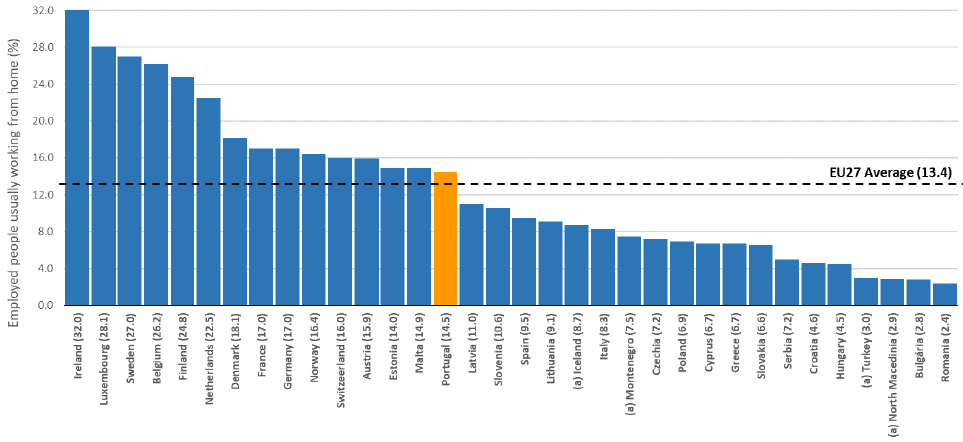
Figure 1. Employed people primarily working from home in Europe 2021 (%) [5].